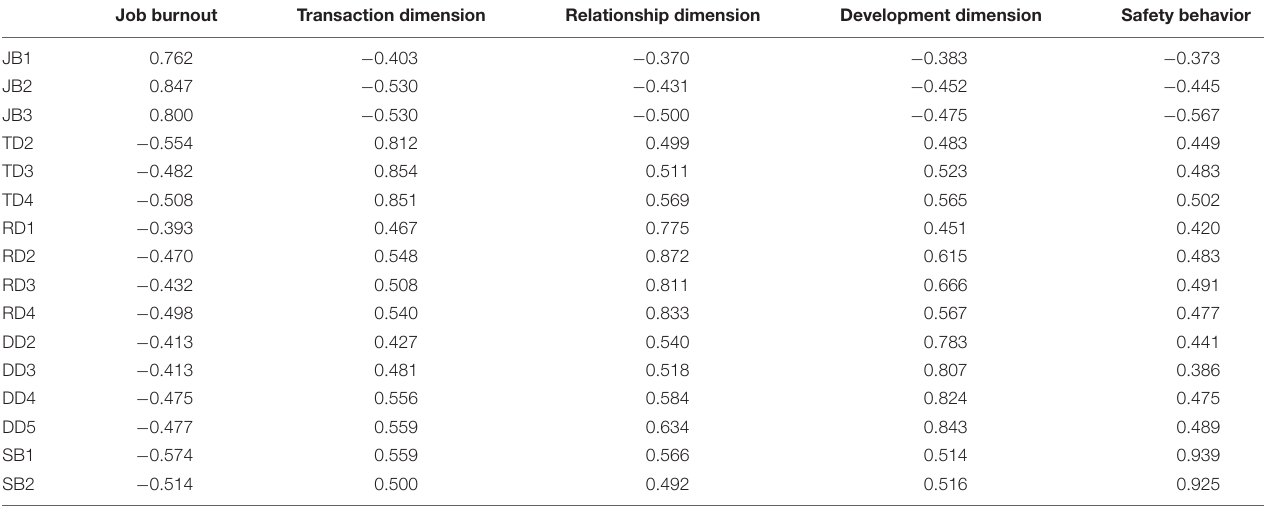
TABLE 5 | Cross loading of variables ( N = 353).